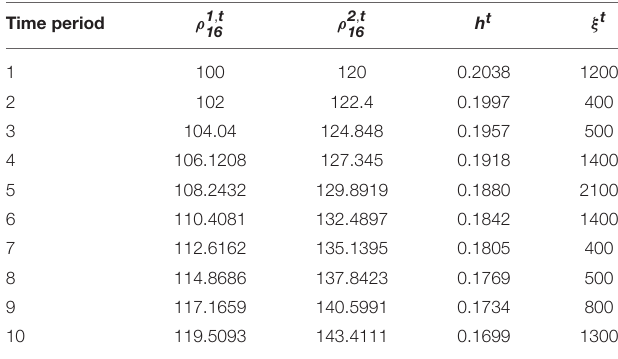
TABLE 2 | Issued credit rates, potential travel demand, and emissions coefficients over the planning